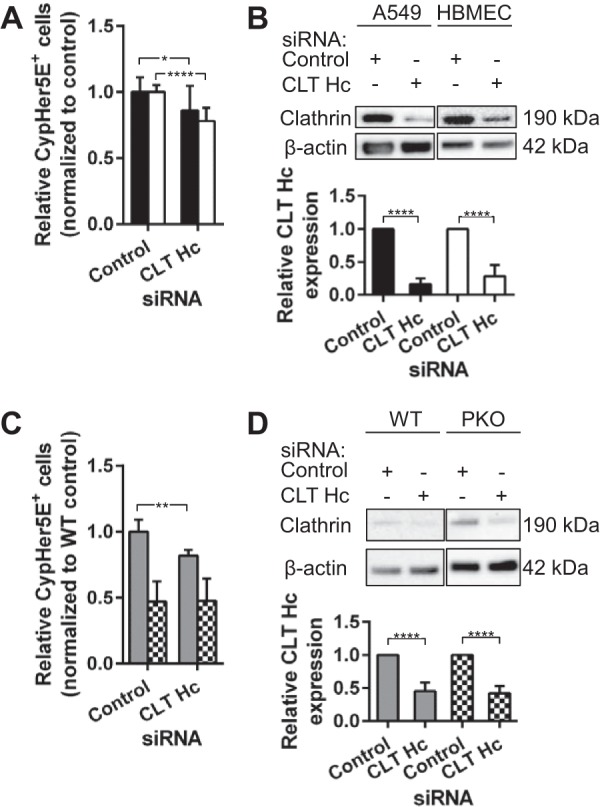
CW uptake via PAFr is clathrin dependent. (A) A549 cells (black bars) and HBMEC (white bars) transfected with siRNAs targeting clathrin heavy chain (CLT Hc) were incubated with CypHer5E-labeled CW and processed and analyzed as described in the legend to Fig. 1C. Data are presented as means plus SD from at least three independent experiments. *, P < 0.05; ****, P < 0.0001 (Student’s t test). (B, top) Representative Western blots showing the CLT Hc protein levels in cell lysates harvested from A549 cells and HBMEC transfected with siRNAs as described above for panel A. (Bottom) Densitometric quantification of CLT Hc expression level in cell lysates in top panel. Protein level was normalized to β-actin. ****, P < 0.0001 (Student’s t test). (C) WT MLEC (gray bars) and PAFr KO MLEC (checkerboard bars) transfected with siRNAs targeting CLT Hc were incubated with CypHer5E-labeled CW and processed and analyzed as described in the legend to Fig. 1C. Data are presented as means plus SD from at least three independent experiments. **, P < 0.01 (Student’s t test). (D, top) Representative Western blots showing the CLT Hc protein levels in cell lysates harvested from MLEC transfected with siRNAs as described above in the legend to panel C. (Bottom) Densitometric quantification of CLT Hc expression level in cell lysates in the top panel. Protein level was normalized to β-actin. ****, P < 0.0001 (Student’s t test). PKO, PAFr KO.